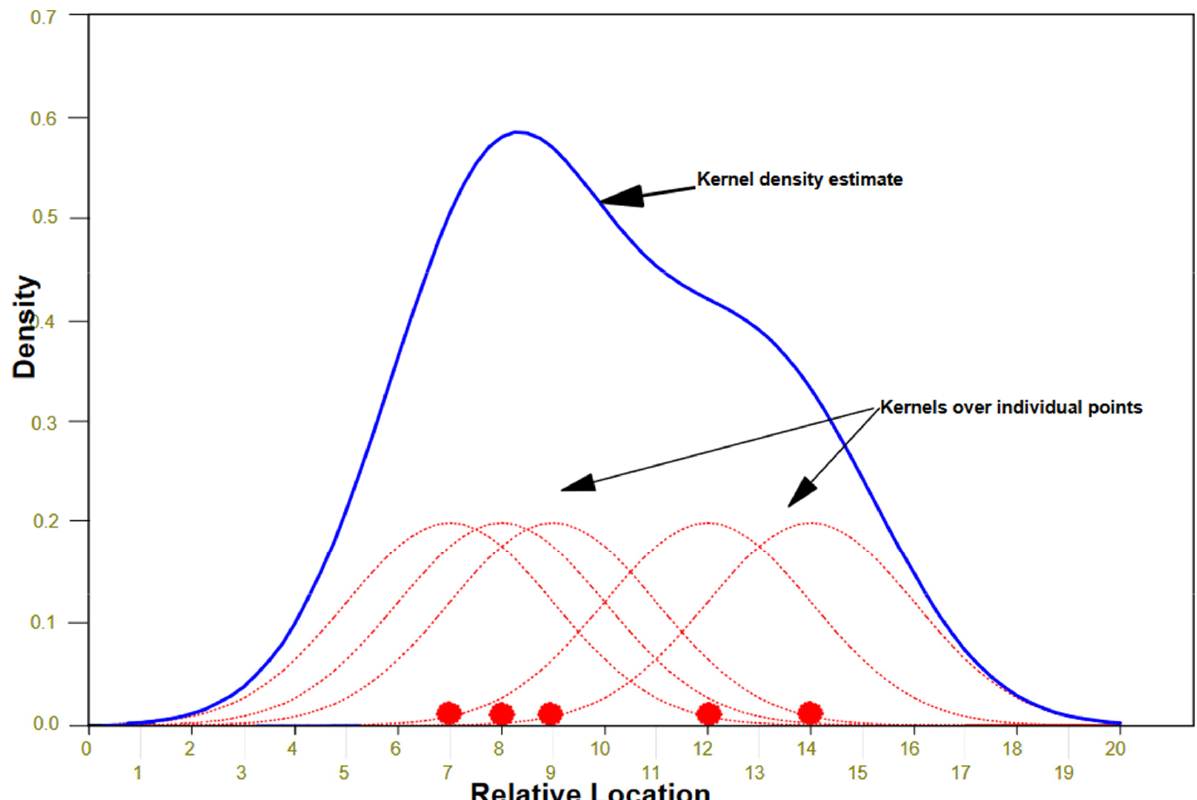
Figure 2. Kernel-density function [14]. Reprinted with permission from Levine [14]. 2019,